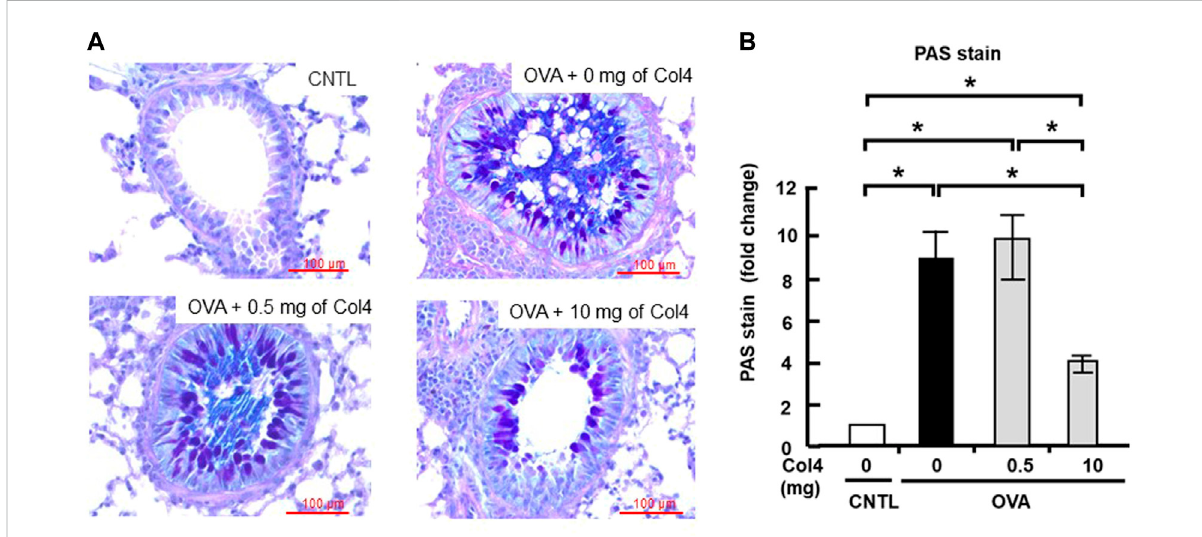
FIGURE 6 Effects ofCol4 oncellular mucuslevelsinovalbumin (OVA)-sensitizedmice. (A) The OVA-sensitized mice were exposed to Col4 (0 – 10 mg).After 24 hofCol4exposure, mucusinthelungtissuesectionswasstainedwith Alcianblueandperiodicacid – Schiff(PAS)andobservedunder amicroscope. The mucus was dyed in purple color. Representative results are presented. Red bars indicate 100 μ m. (B) The staining intensity was quanti fi ed and compared using ImageJ (Fiji) with fi ve independent images. A one-way analysis of variance was used to obtain the p -values. Asterisks indicate statistical signi fi cance, * p < 0.05. The control mice and the mice treated with 0 mg of Col4 were exposed to PBS alone at the same time.